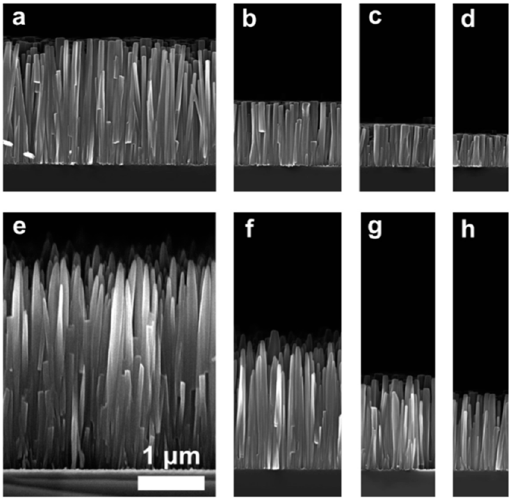
Figure 18. SEM micrographs showing cross-section images of the ZnO nanowires at low flow rates ( a – d ) and high flow rates ( e – h ). Reprinted with permission from [72]. Copyright (2009) American Chemical Society.